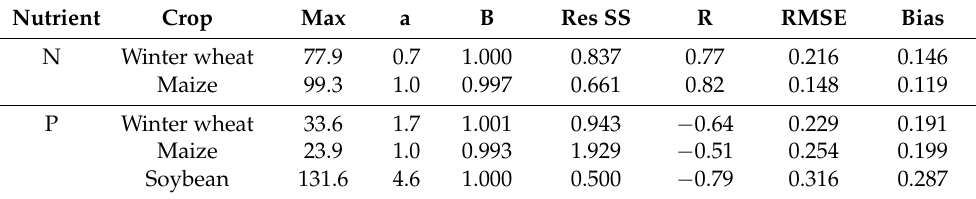
Table A6. Interpolation parameters for the hyperbolic model applied to the long-term experiment data for nitrogen (N) and phosphorus (P). Max, a, and b are regression parameters and Res SS, RMSE, and Bias are the model residual sum of squares, root mean square error, and bias, respectively.